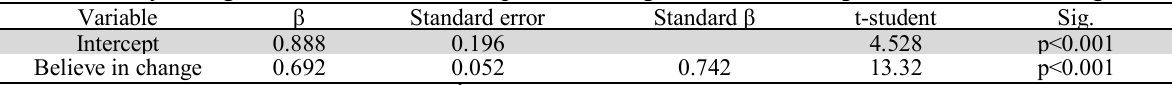
The summary of regression model between perceived organizational change and believe in change Variable β Standard error Standard β t-student Sig. Intercept 0.888